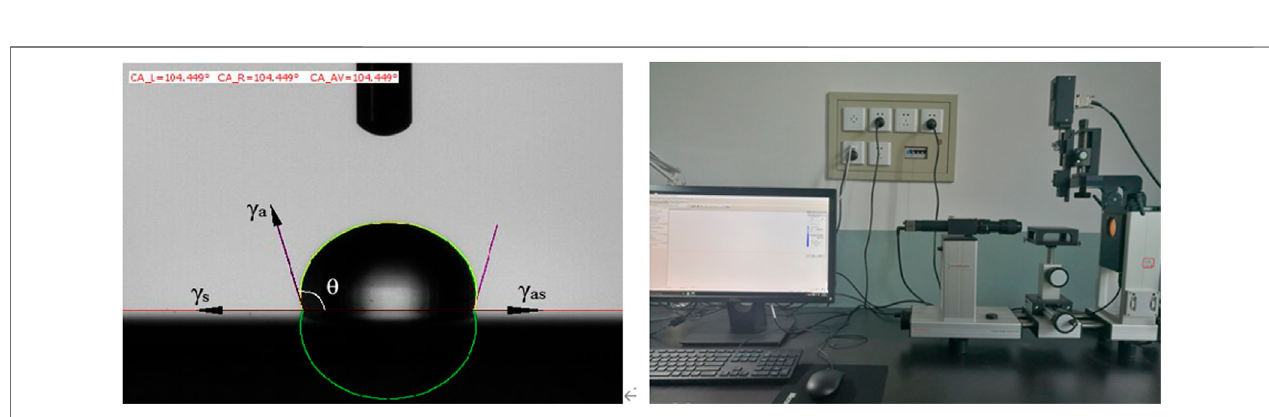
FIGURE 2 | Schematic representation of the contact angle formed between a probe liquid and an asphalt surface and drop shape analyser (OCA25).